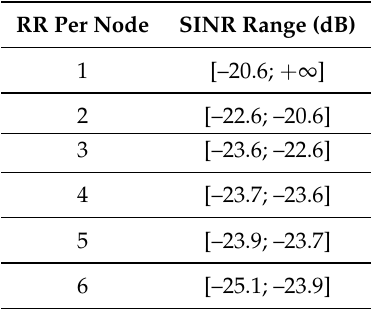
Table 2. MCS table: SINR versus RR required to achieve R = 500 bps.